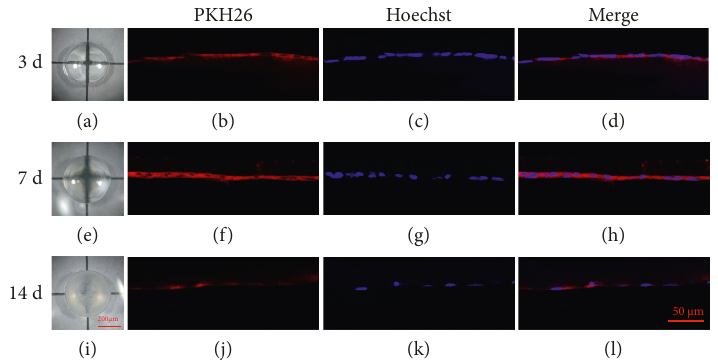
Figure 4: Uptake of PKH26-labeled exosomes by LECs sub anterior capsule of lenses cultured ex vivo. (a, e, i) Photographs of lenses cultured ex vivo for 3 days, 7days and 14 days. Scale bar 1 � 200 μ m. (b–d) Fluorescent photographs of frozen sections from lenses cultured for 3 days. (f–h) Fluorescent photographs of frozen sections from lenses cultured for 7 days. (j–l) Fluorescent photographs of frozen sections from lenses cultured for 14 days. Red represents PKH26; blue represents the nucleus. Scale bar 2 � 50 μ m